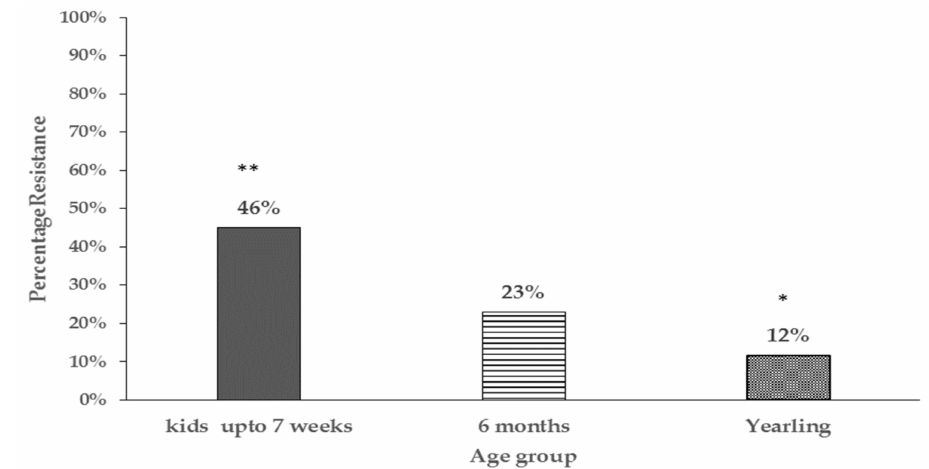
Figure 2. Bar chart comparing percentage of resistant E. coli isolates in di ff erent age groups of pastured goat kids (only goat kids sampled at pasture are represented). Proportions with di ff erent number of asterisks ** vs. * are significantly di ff erent ( P < 0.05).